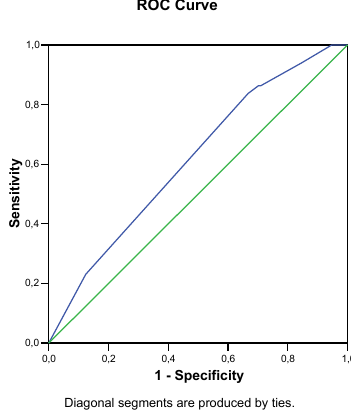
Figure 1. ROC (Receiver Operating Characteristics) curves displaying the relationship beetwen sensitivity and specificity that defined influenza in adults (left figure) and children (right figure).